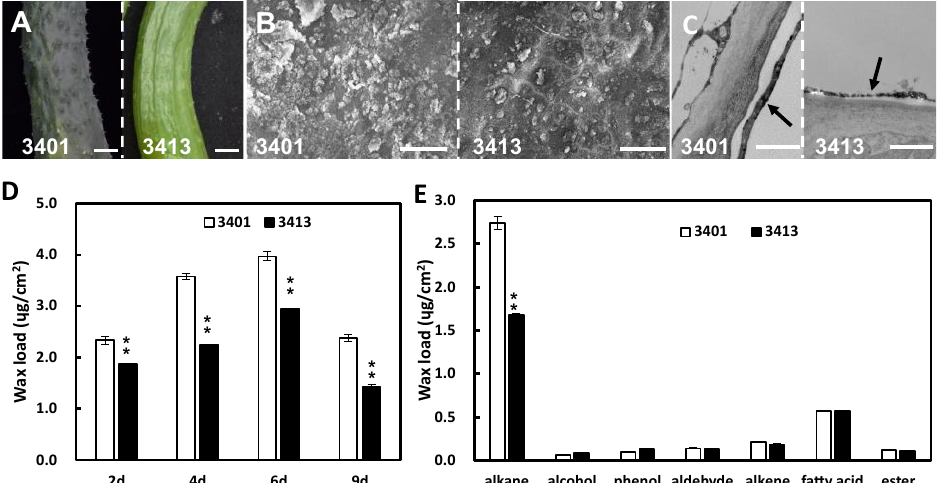
Figure 1. The phenotype of fruit cuticle in cucumber 3401 and 3413. ( A ) The fruit image of 3401 and 3413 at 9 days after anthesis (DAA). ( B ) The SEM pictures of the fruit cuticle, respectively, at 9 DAA in 3401 and 3413. ( C ) The TEM pictures of the fruit cuticle at 9 DAA in 3401 and 3413. The black arrow indicates wax layer. ( D ) Cuticular wax loads for fruit surface at 2, 4, 6, and 9 DAA in 3401 and 3413. ( E ) Contents of wax components in 3401 and 3413 at 6 DAA. The data of columns are the mean ± standard deviation. ** means p < 0.01, Student’s t -test. Scale bars = 1 cm in ( A ); 200 µm in ( B ); 1 µm in ( C ).